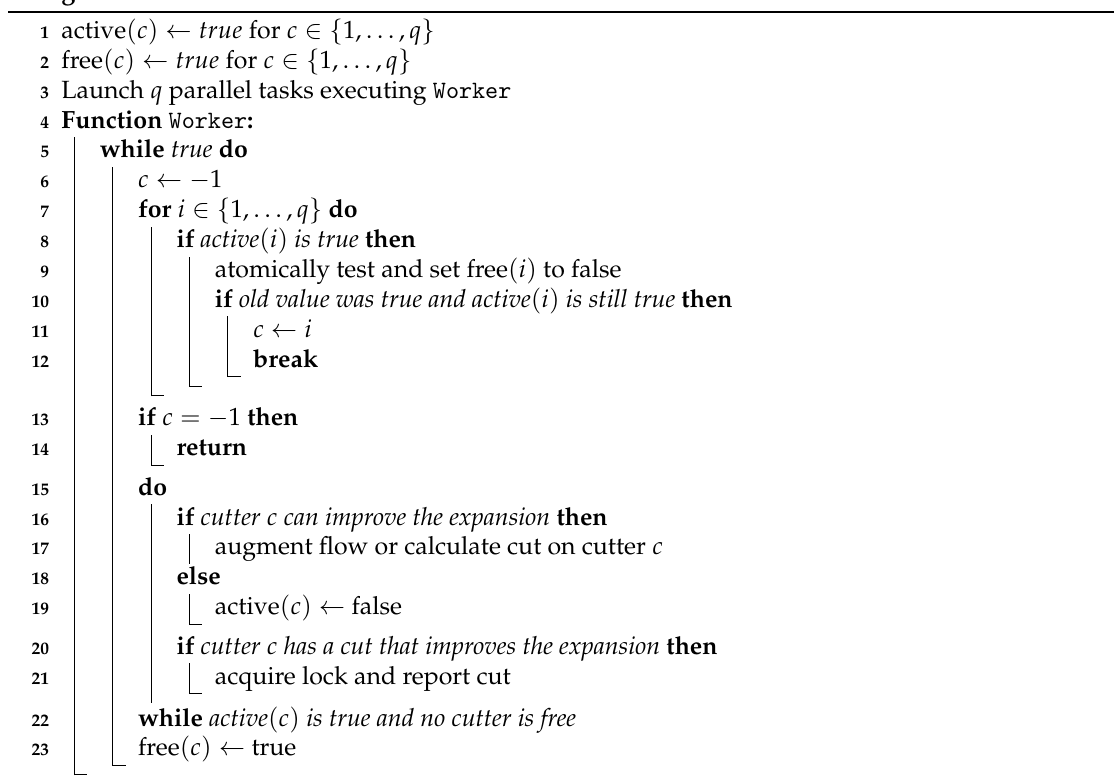
Algorithm 2: Parallel InertialFlowCutter